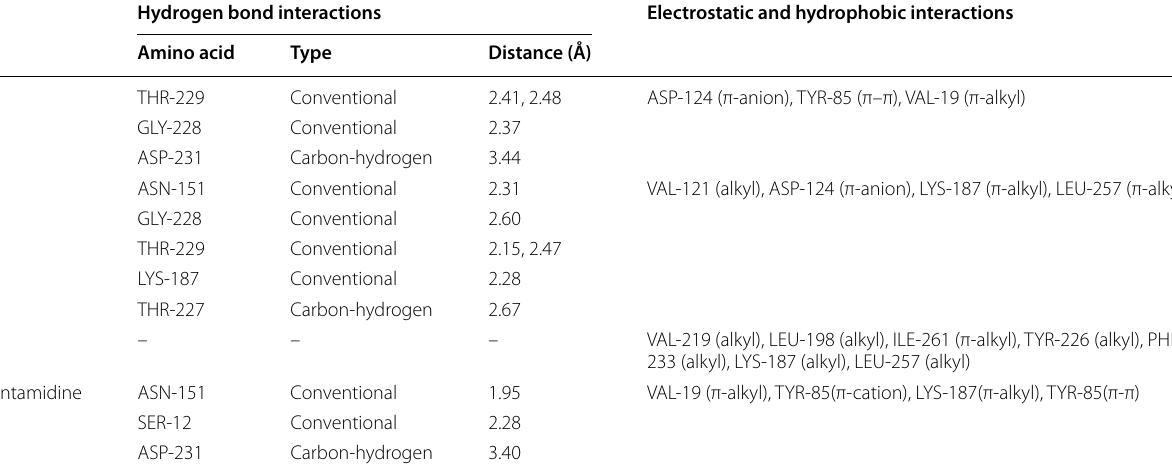
ASN asparagine, ASP aspartic acid, GLY glycine, ILE isoleucine, LEU leucine, LYS lysine, PHE phenylalanine, SER serine, THR threonine, TYR tyrosine, VAL valine